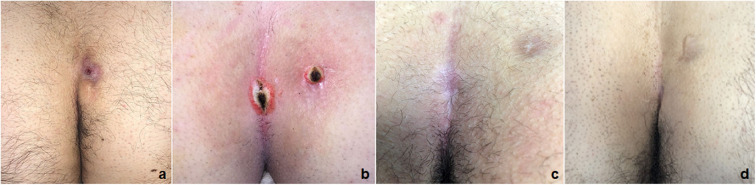
PEPSiT protocol steps: 1. Pre-operative laser epilation (a); 2. PEPSiT (b); 3. Post-operative laser epilation (c); Final result (d).